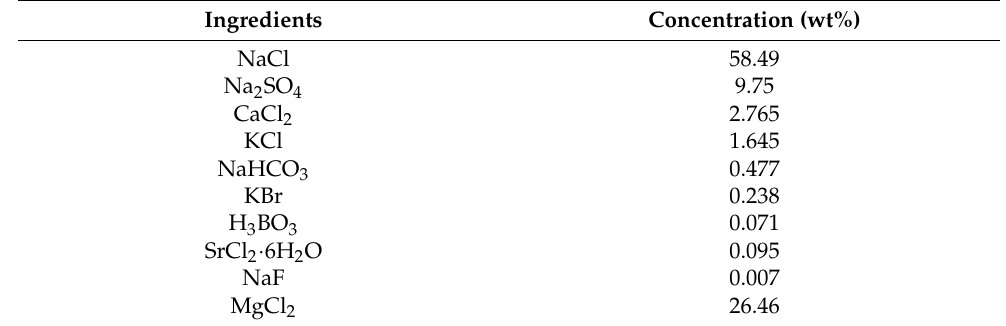
Table 2. Composition of artificial sea